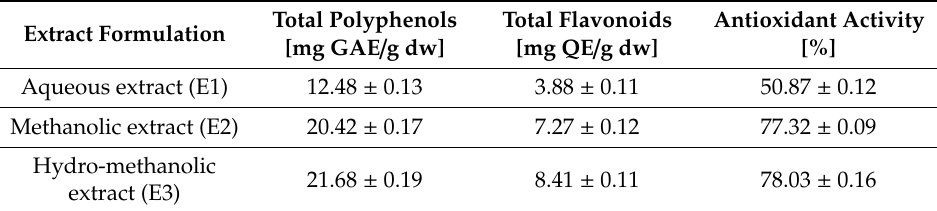
Table 2. Total polyphenolic and flavonoid content, along with antioxidant activity of the three formulations of the bilberry ripe fruit